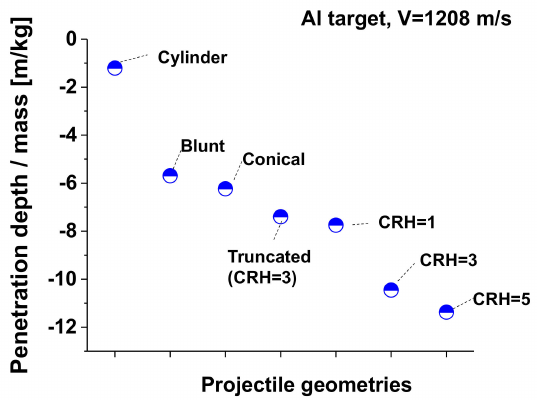
Figure 10. Penetration depth / mass distribution with respect to the projectile geometries.